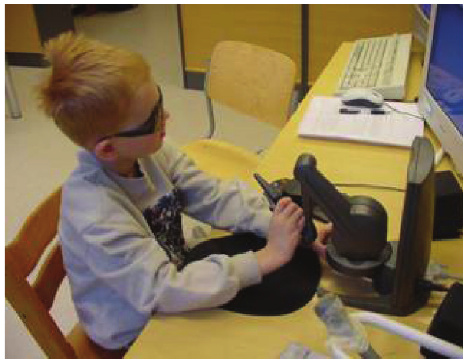
Figure 2: Multimodal interface